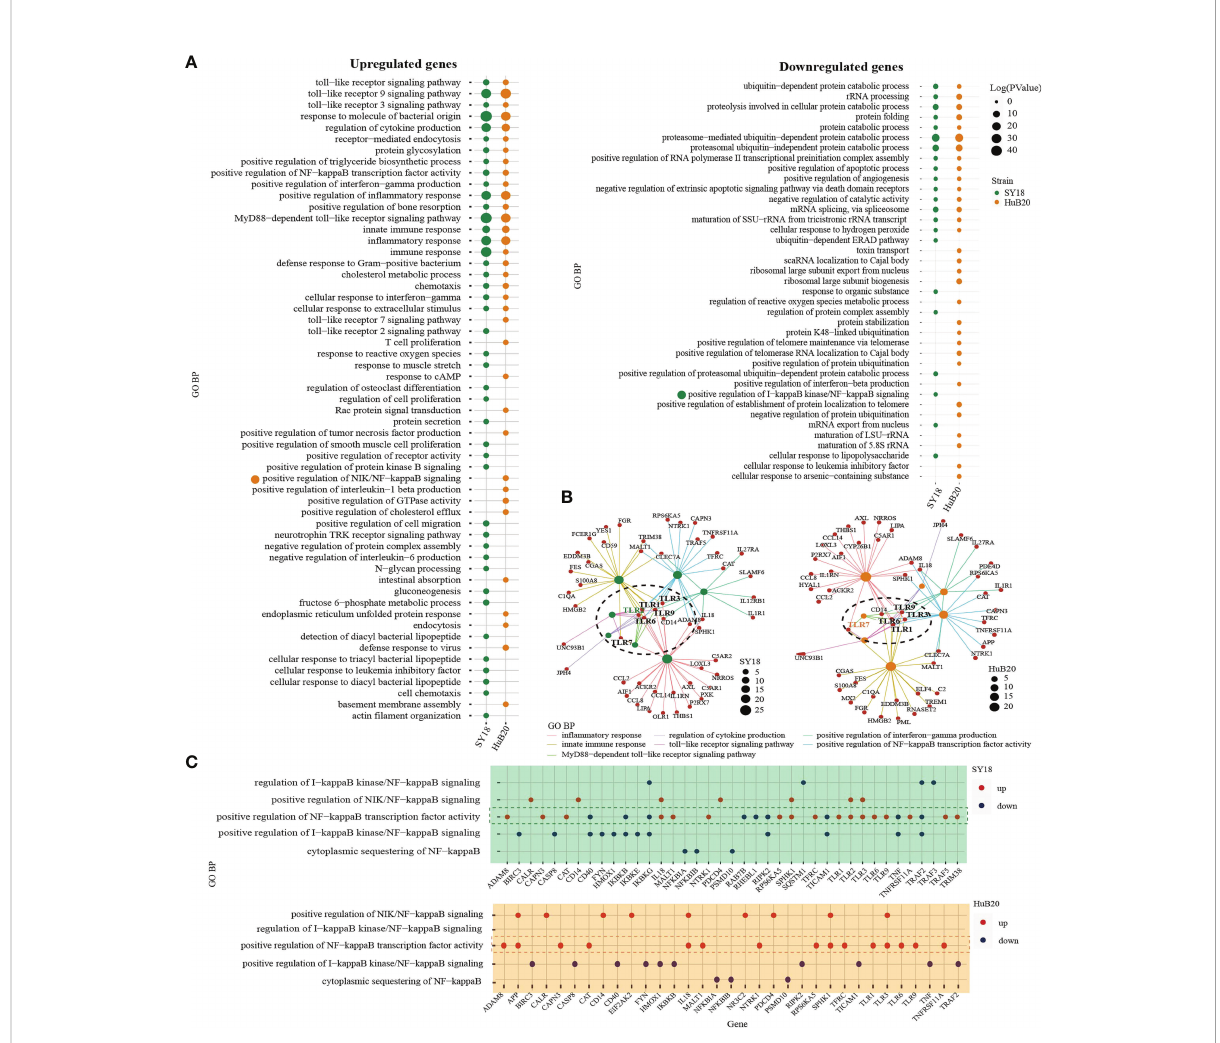
FIGURE 4 GO analysis of the genes with expression changes at 6, 12, 24, and 48 hpi. (A) Gene ontology biological processes (GO-BP) enrichment analysis of upregulated (left) and downregulated (right) DEGs ( P < 10 -10 ) of the two strains separately, and the bubble plot shows the GO terms with P < 0.01 . (B) The network shows the relationship of most enriched up-regulated GO terms in PAMs after being infected by SY18 (left) and HuB20 (right) strains. (C) Dot plots of NF-kappaB related GO terms enriched by DEGs of PAMs after being infected by SY18 (top) or HuB20 (bottom)